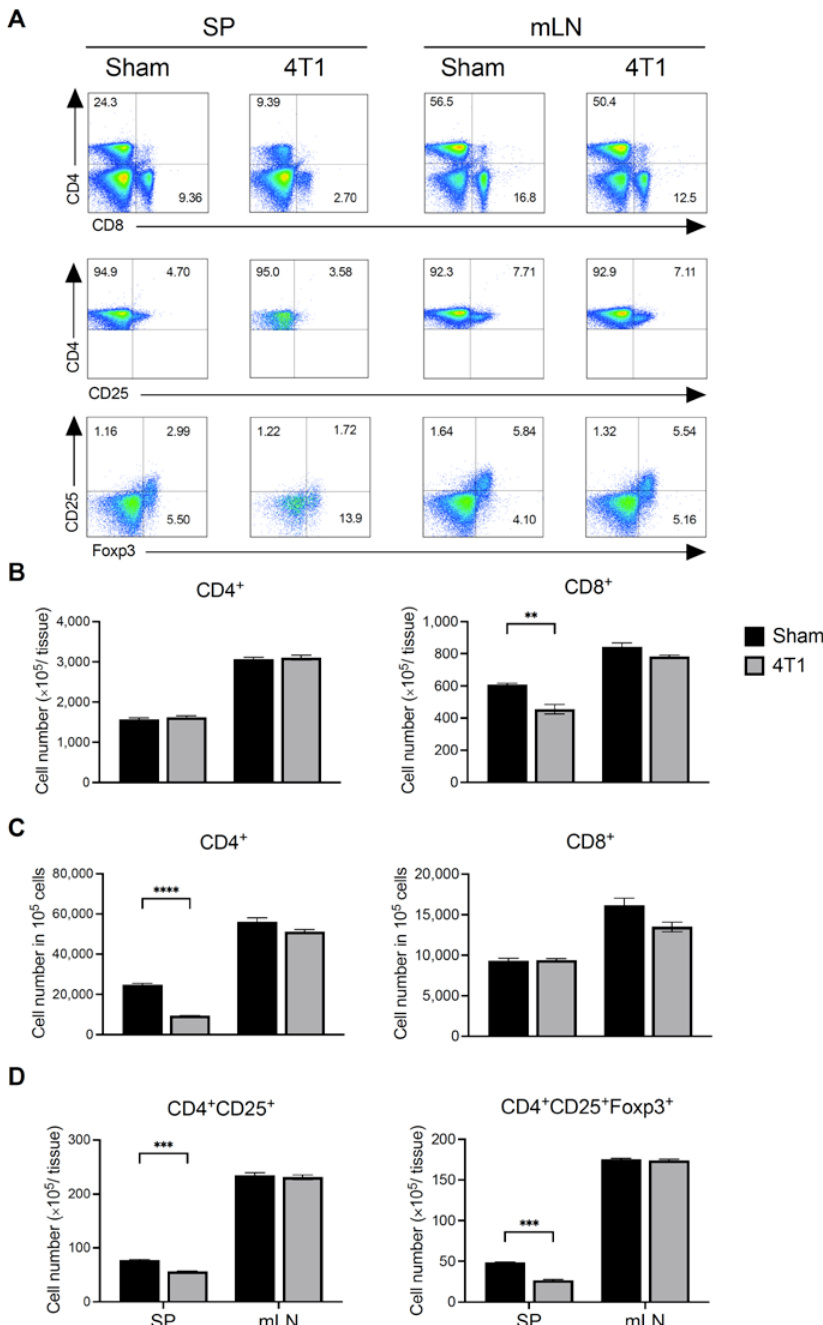
Figure 2. Splenic and mLN T cell subsets in subcutaneously transplanted 4T1 tumor mice. At day 21 after subcutaneous transplantation into the right flank transplantation, the splenocytes and mLN cells from control (Sham) or tumor (4T1)-bearing mice were isolated. ( A ) Representative pseudocolor dot plot of CD4 + , CD8 + , CD4 + CD25 + , and CD4 + CD25 + Foxp3 + in the spleen and mLN. Numbers in plots indicate the percentage. ( B ) Total cell number of CD4 + and CD8 + T cells in the tissues. ( C ) Cell number of CD4 + and CD8 + T cells per 10 5 cells. ( D ) Total cell number of CD4 + CD25 + cells and CD4 + CD25 + FoxP3 + Treg cells in the tissue. Data are presented as mean ± SEM and were assessed by Mann–Whitney U test. Data are shown from a representative experiment from three independent experiments. ** p < 0.01; *** p < 0.005; **** p < 0.001.